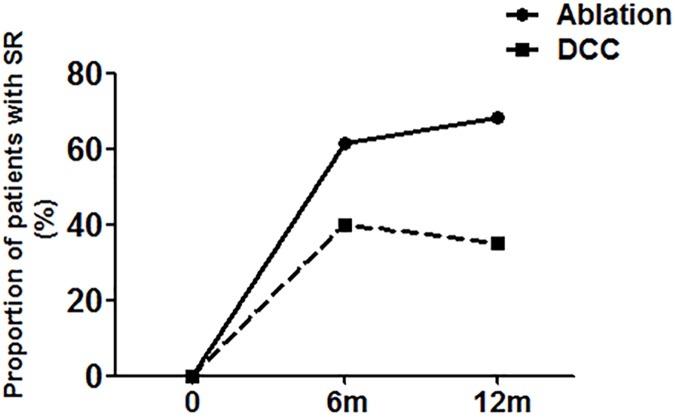
Comparison of proportion of patients with SR at 6 and 12 months between ablation and DCC groups.DCC, direct current cardioversion.